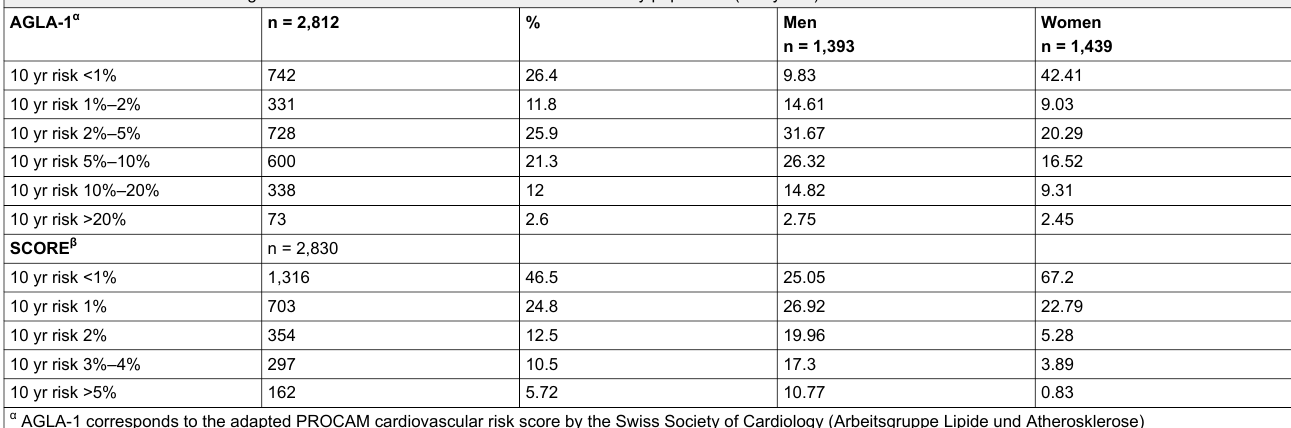
Table 1: Prevalence of risk categories AGLA-1 and SCORE – in the SAPALDIA study population (≥50 years). AGLA-1 α n = 2,812 % Men